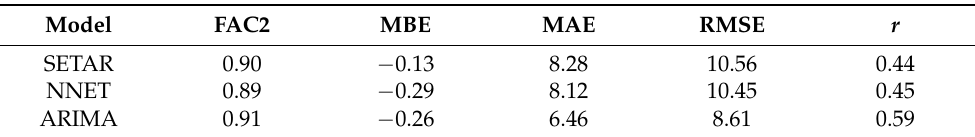
Table 3. Comparing the performances of different models, including both linear and nonlinear models, using the testing dataset (cross validation). MBE, MAE and RMSE are expressed in µ g/m 3 . r is the value of correlation coefficient.